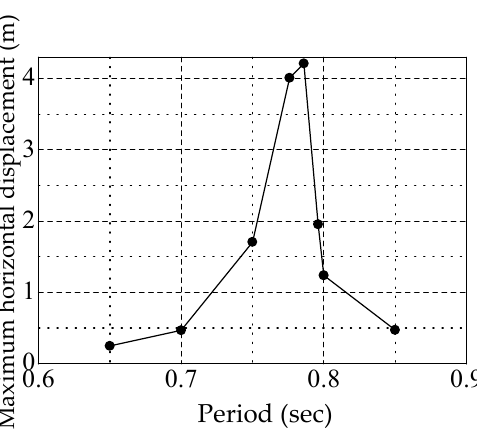
Figure A3. Each period and maximum horizontal displacement.